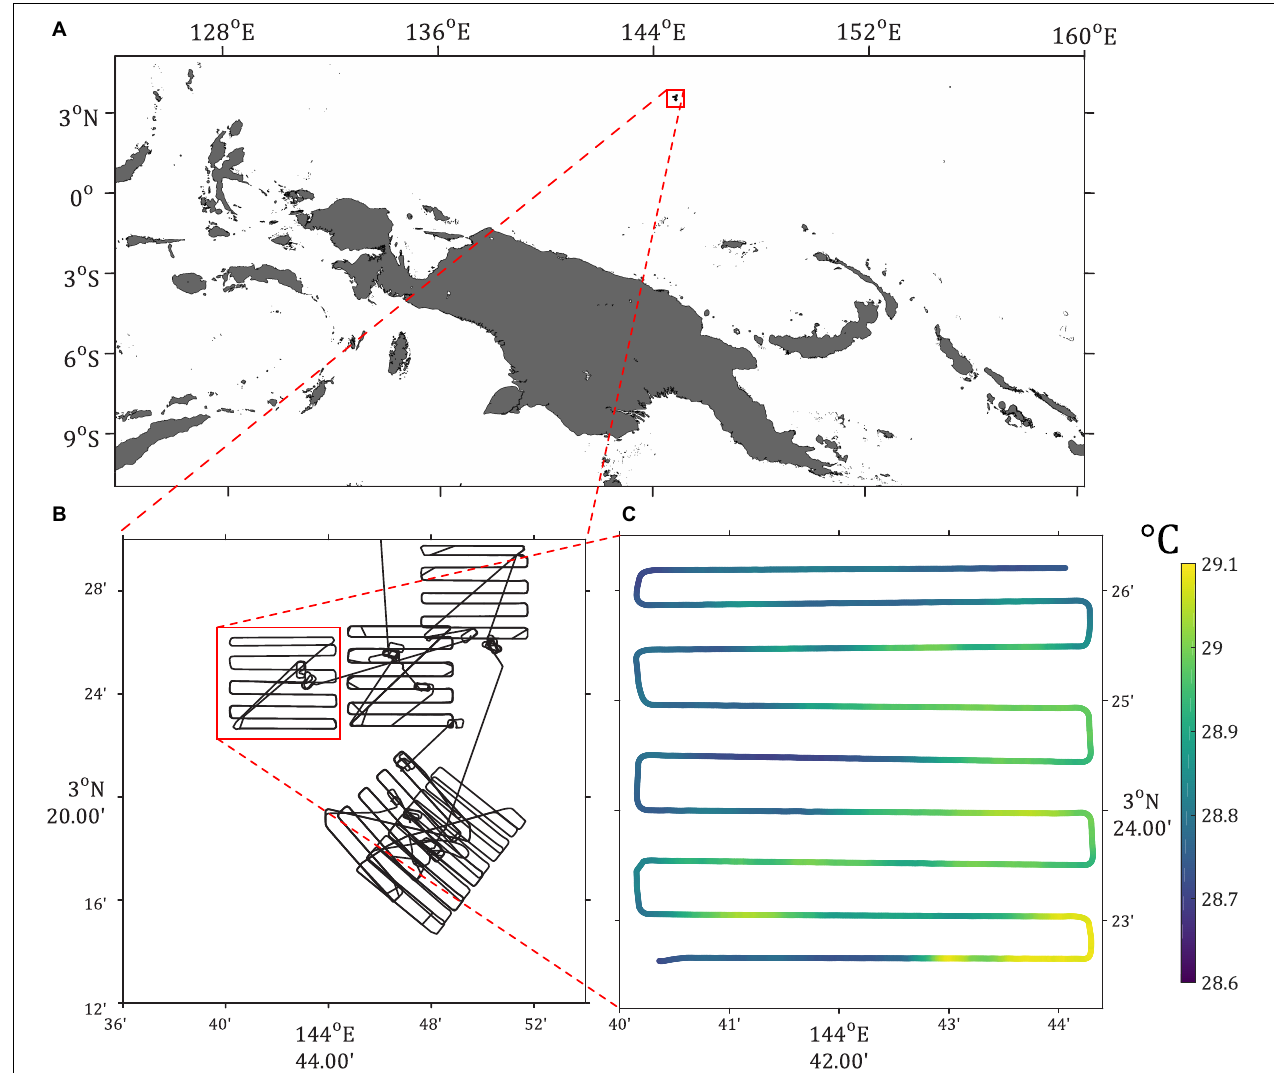
FIGURE 3 | (A) Map of the Western Equatorial Pacific Ocean. Red boxes represent progressive zooms showing several example flight tracks (B) and a single track (C) , colored by the sea surface brightness temperature in ◦ Celsius. The flight in the final panel occurred on November 2nd, 2016 at 0500 UTC. Surface temperature standard deviations: 0.282 ◦ C (CT09 on UAV), 0.157 ◦ C (MODIS on